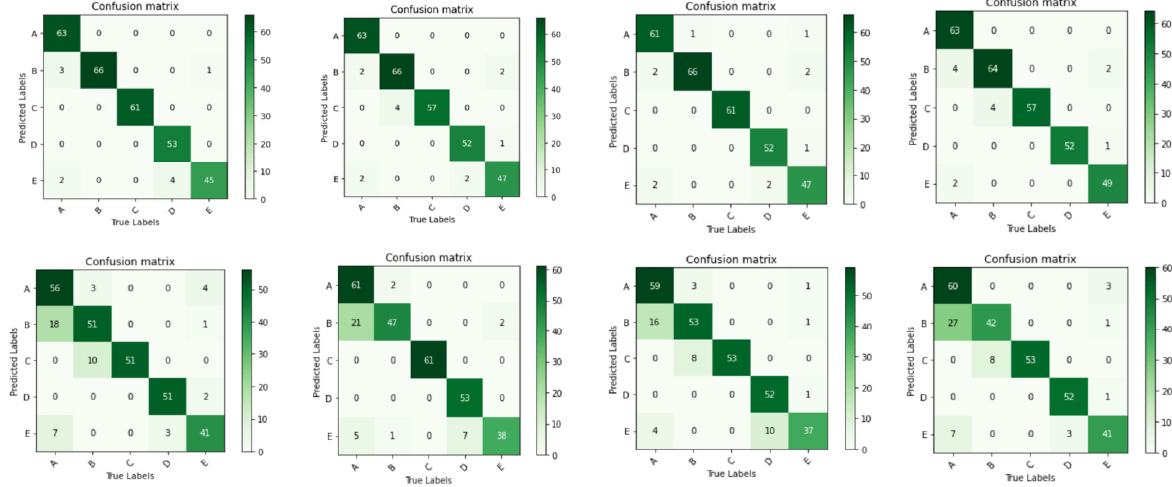
Figure 11. Confusion matrices of Models 1–8 on the test set.